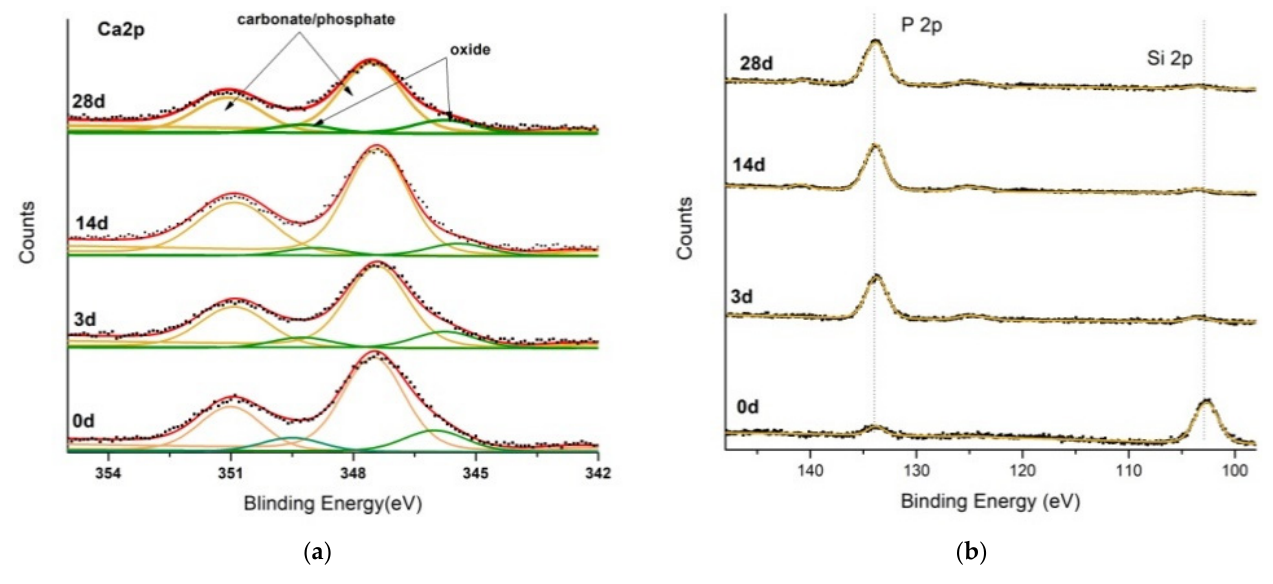
Figure 4. XPS spectra of the coated polymeric scaffold at different soaking time in SBF solution: 0 (0d), 3 (3d), 14 (14d) and 28 days (28d). ( a ) Ca2p region; ( b ) P2p ‐ Si2p region.